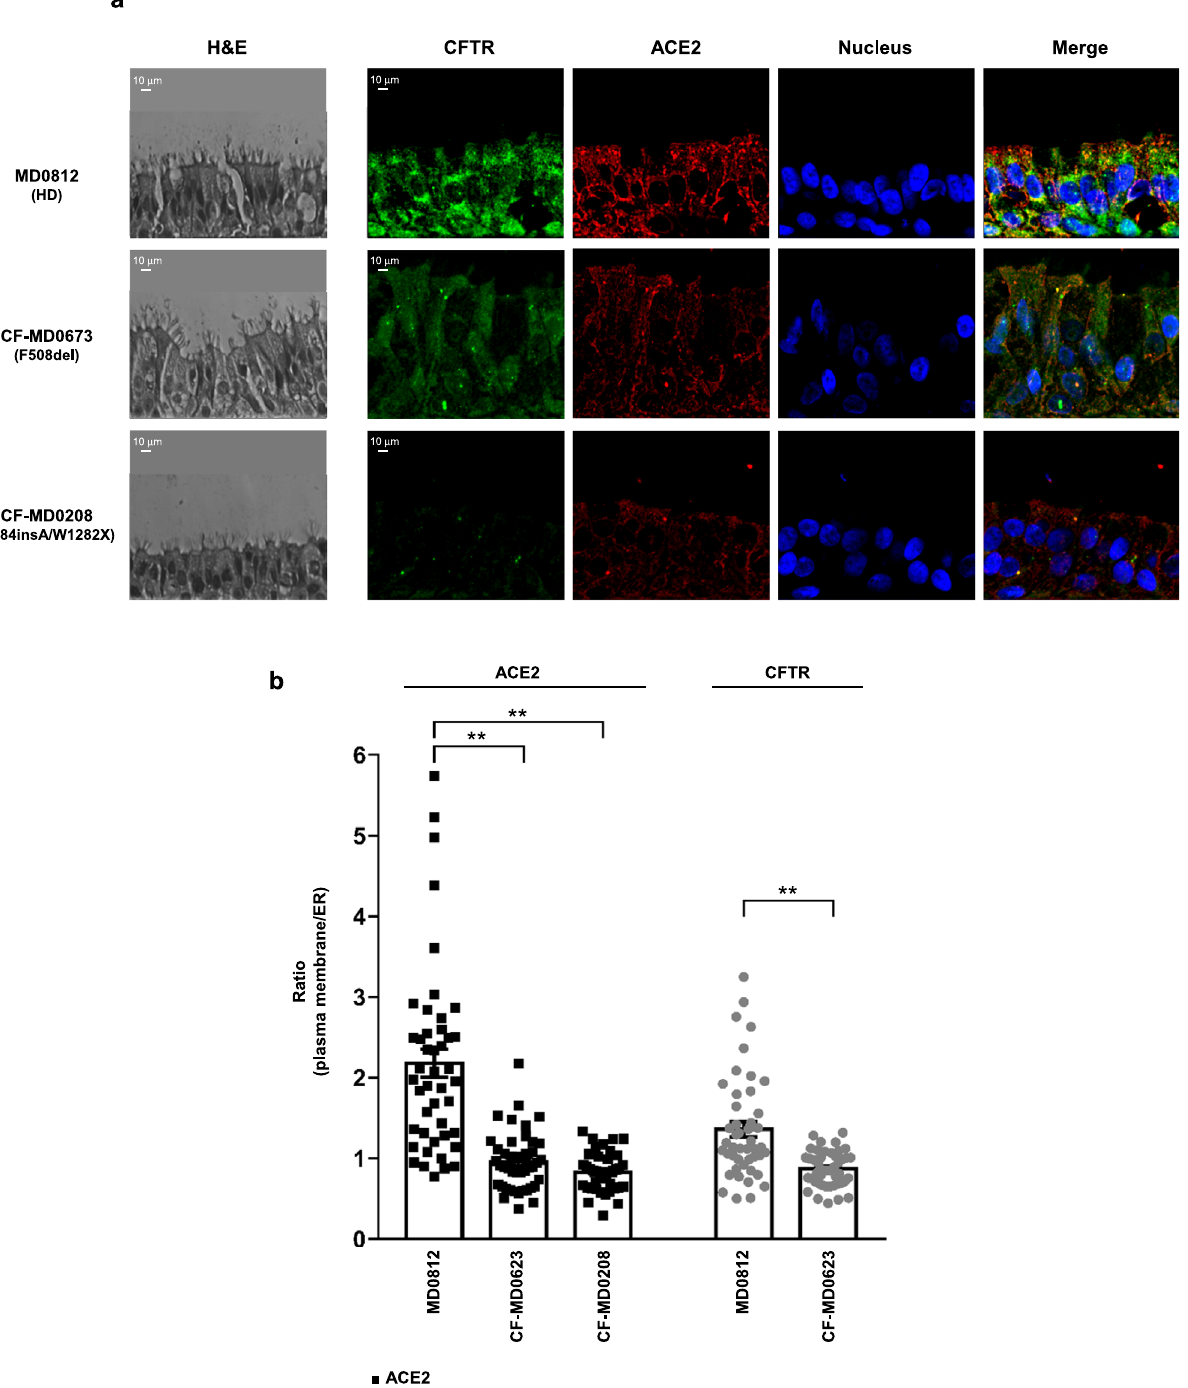
Fig. 5 | Distribution of ACE2 and CFTR in primary air – liquid interface differ- entiated hBEC obtained from healthy donors and CF patients. a Immuno fl uorescence detection of ACE2 and CFTR in primary well-differentiated hBEC obtained from an healthy donor (HD, MD0812), CF patient homozygous for F508del- CFTR mutation (CF-MD0673) and CF patient with genotype 2184insA/ W1282X CFTR (CF-MD0208). H/E images have been reported to show the cell structure of primary air-liquid interface differentiated hBEC obtained from donor and CF patients. The images were acquired with a confocal laser scanner Olympus